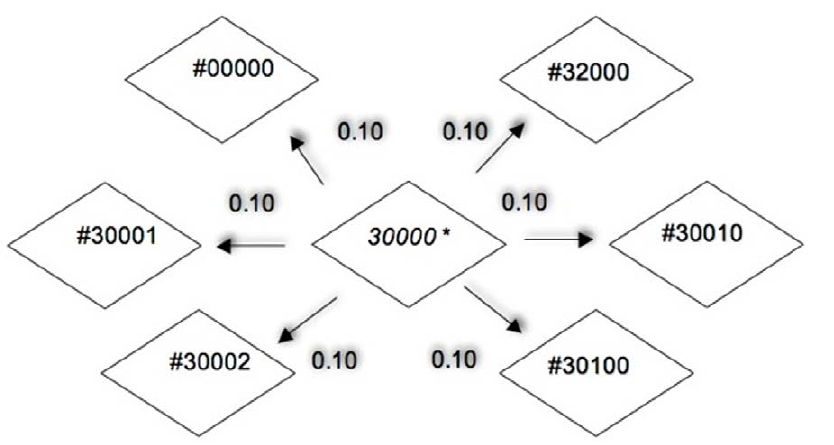
Figure 3. Probability of shift between a histone state and its neighbour. Only one change is possible at each time step hence each histone state can potentially shift to only one of its specific neighbours. *=Current state. # - neighboring state. Probabilities of shift ( [ [0,1]) can be given by the user initially.